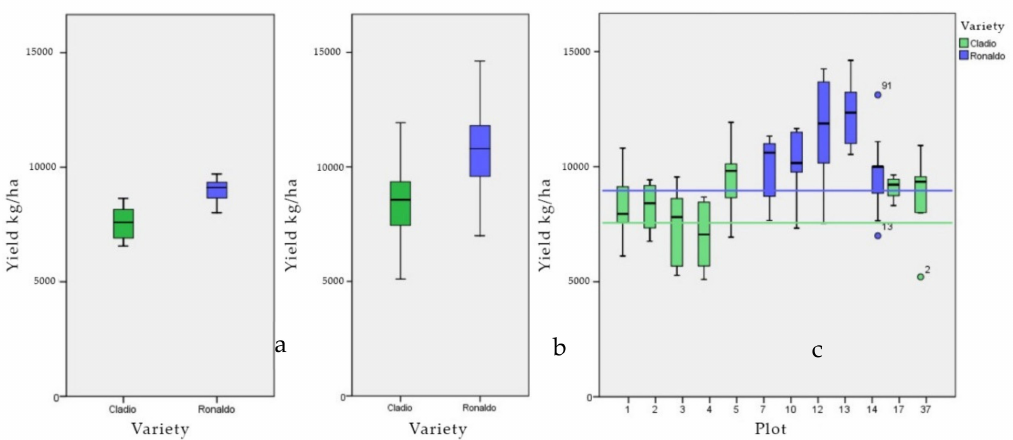
Figure 8. Boxplot ( a ) of yield (in kg/ha) per variety as derived from yield data of 18 the parcels, ( b ) of yield (in kg/ha) per variety as derived from the mean yield data of the 97 sample points, ( c ) of yield (in kg/ha) per variety and plot as derived from the mean yield data of the 97 sample points.